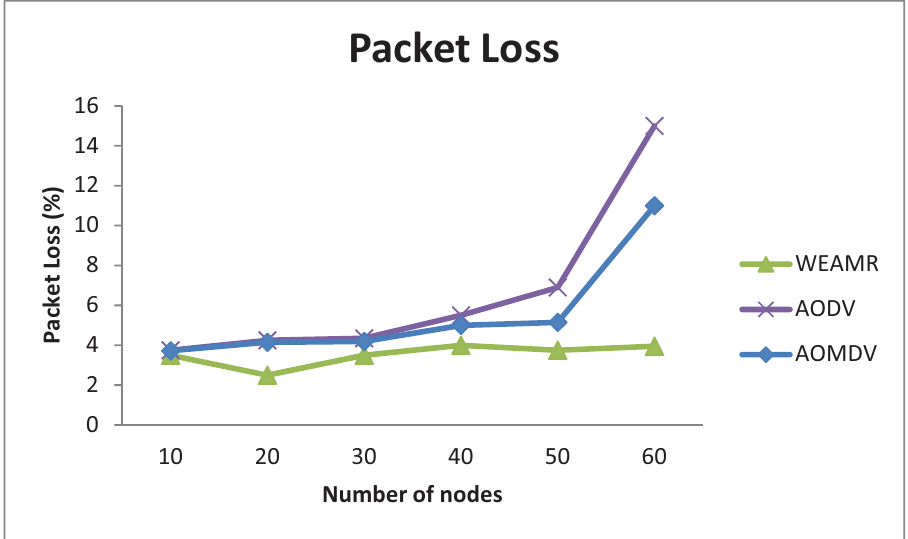
Figure 19. Average packet loss in end to end communication with increasing number of